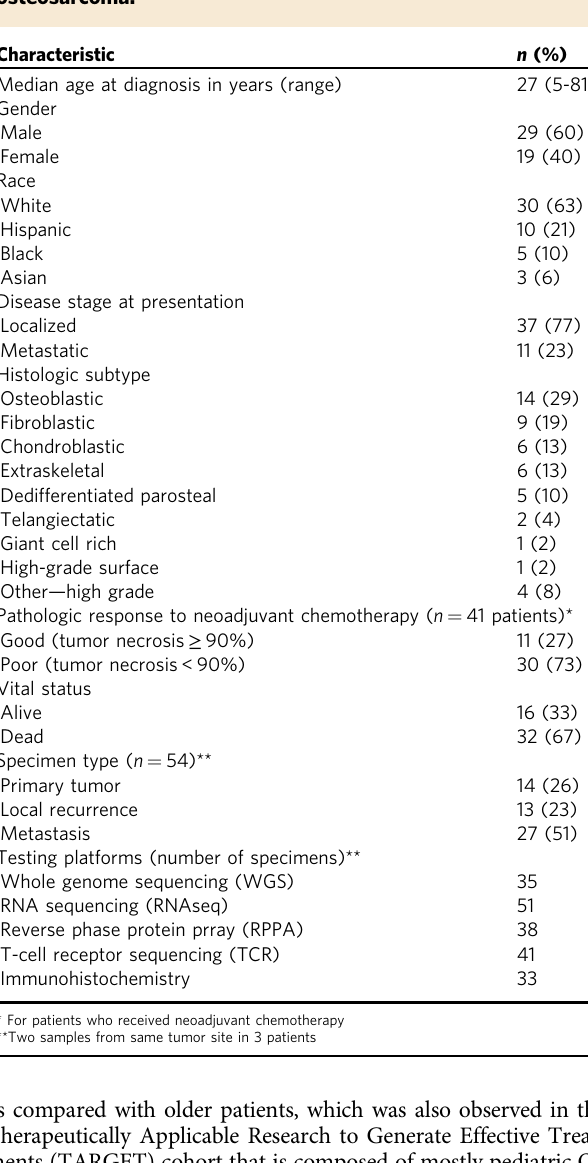
Table 1 Clinical characteristics of 48 patients with